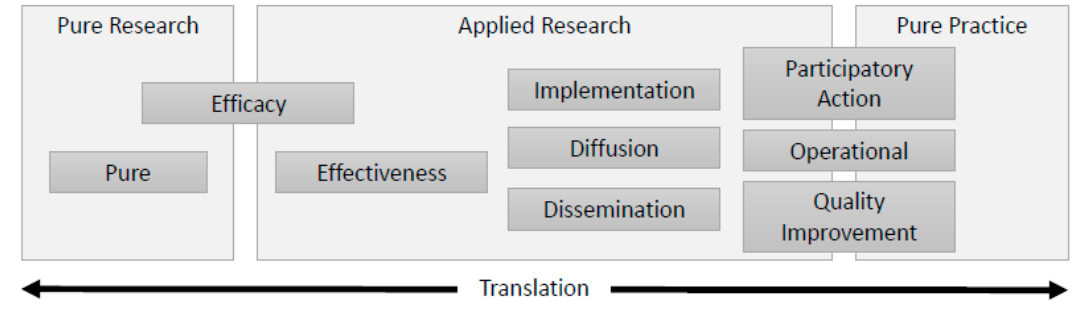
Figure 1. Simplified depiction of the translational research spectrum, wherein traditions have emerged distinctly but may overlap in practice.